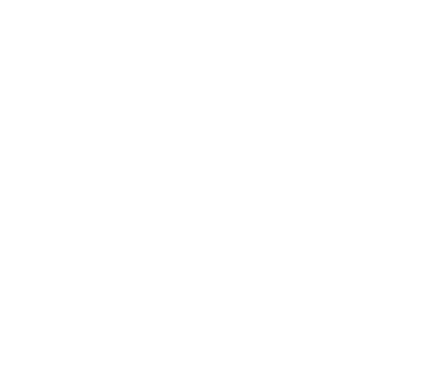
Figure 9 - Diagram illustrating the various X-linked bar pheno- types (original). The picture was selected by clicking the item in the option list shown on the right after pressing the com- mand button “(mutations)